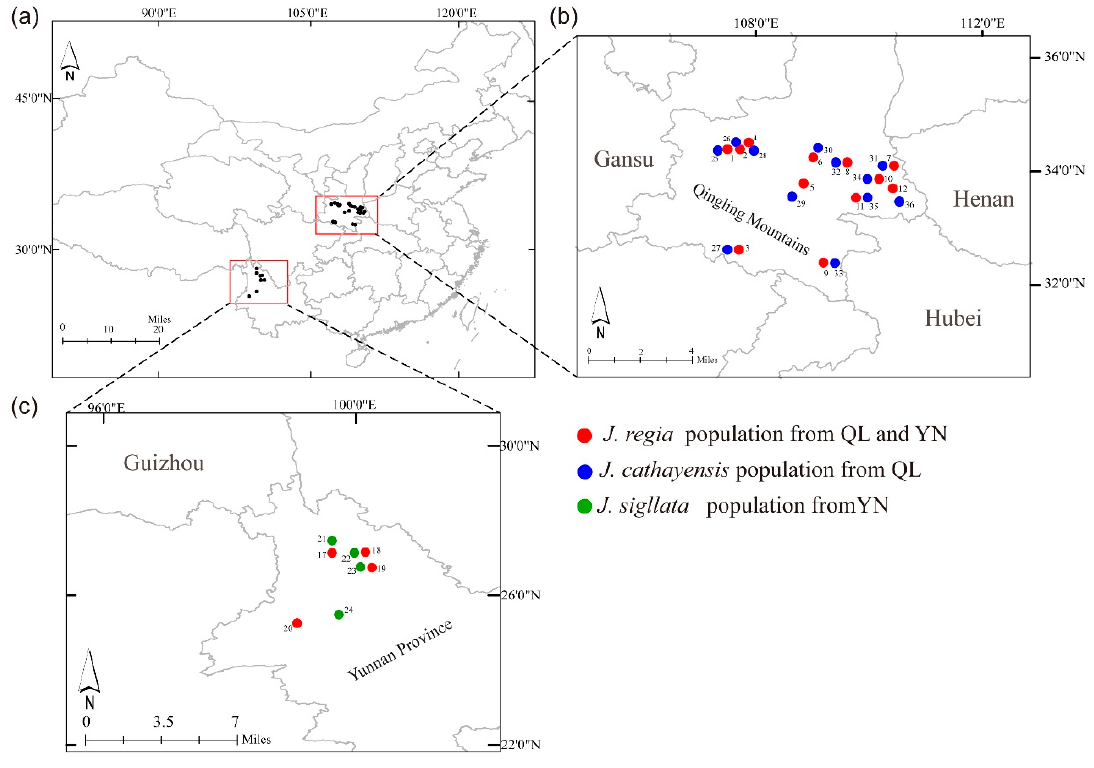
Figure 1. The sample collection information for the three walnuts. ( a ) A total of 656 trees from 40 sites of sympatric Juglans regia and J. cathayensis in the Qinling Mountains and sympatric J. regia and J. sigillata in Yunnan Province. The black dots indicate the population locations. ( b ) The map information for a total of 369 samples from 24 populations from the Qingling Mountains. The red dots and blue dots indicate the locations of the sympatric J. regia (183 individuals) and J. cathayensis (186 individuals), respectively. ( c ) The map information for a total of 178 samples of 8 populations from the Qingling Mountains. The red dots and green dots indicate the locations of the sympatric J. regia (58 individuals) and J. sigillata (120 individuals) populations, respectively.